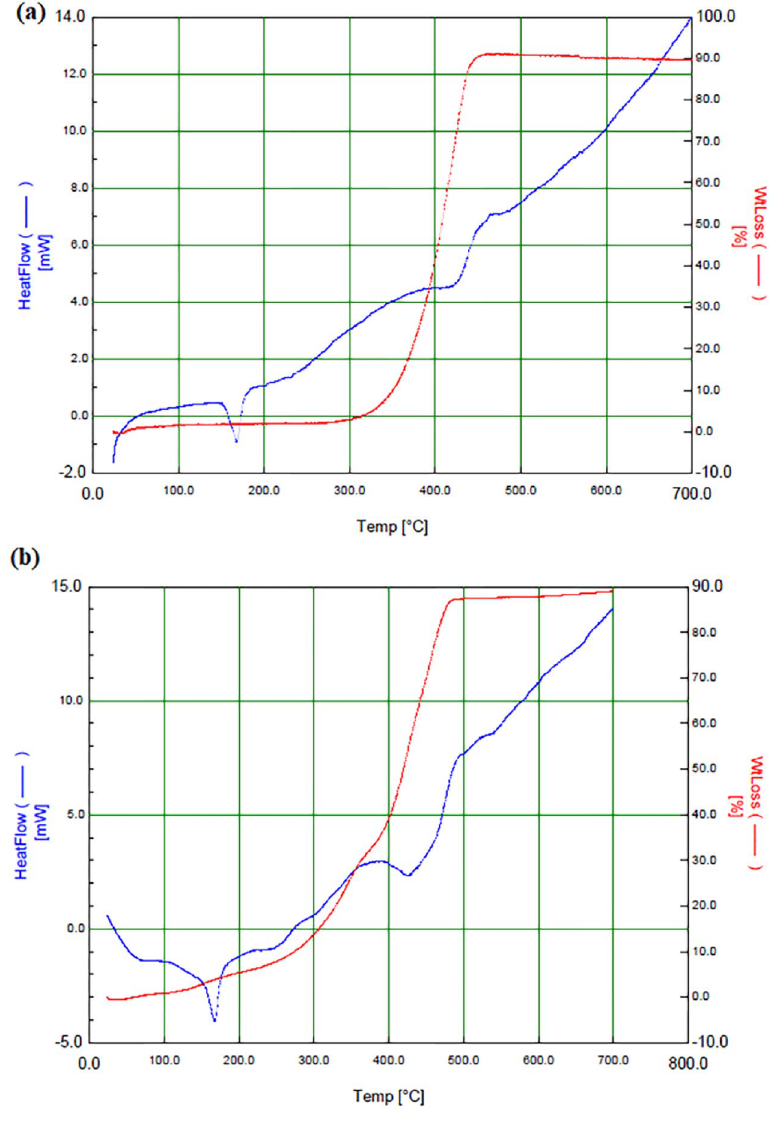
Figure 6. TGA thermograms for PP-nonwoven fabric and amine group modified PP-g-(GMA-co-H 2 PO 3